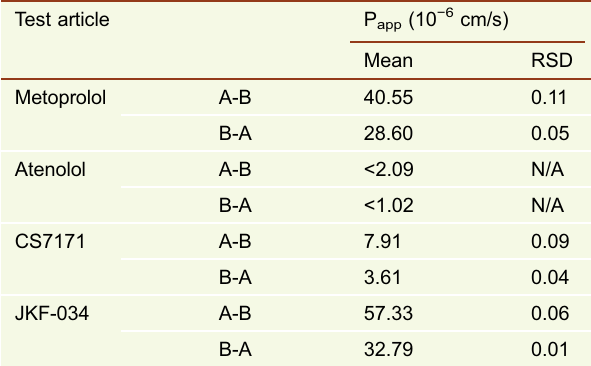
Table 2. Permeability coef fi cient of CS7171 and JKF-034 in the in vitro blood-brain barrier permeability assay. Test article